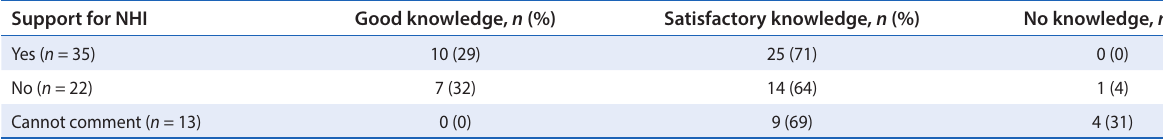
Table 5: Doctors’ awareness of NHI and their support